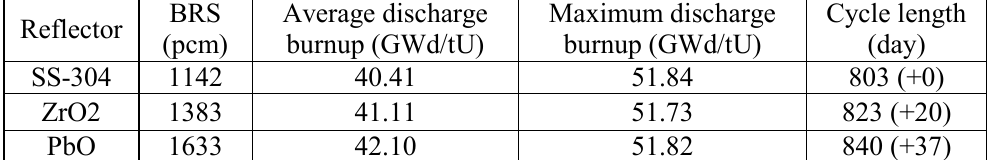
Table V: Neutronic Comparison between Two-batch ATOM Cores with Various Reflectors